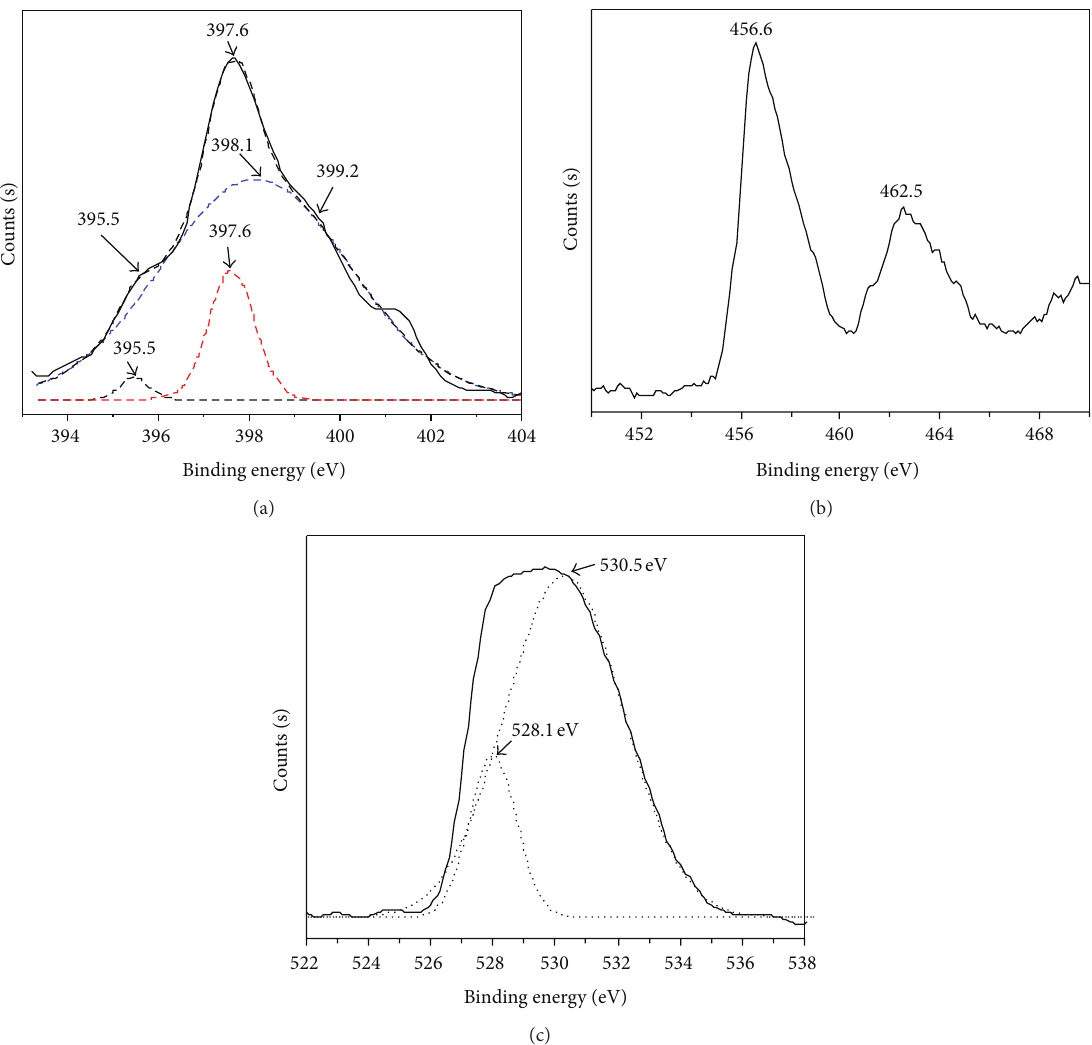
Figure 6: XPS spectra of N 1s (a), Ti 2p (b), and O 1s (c) for N-TiO 2